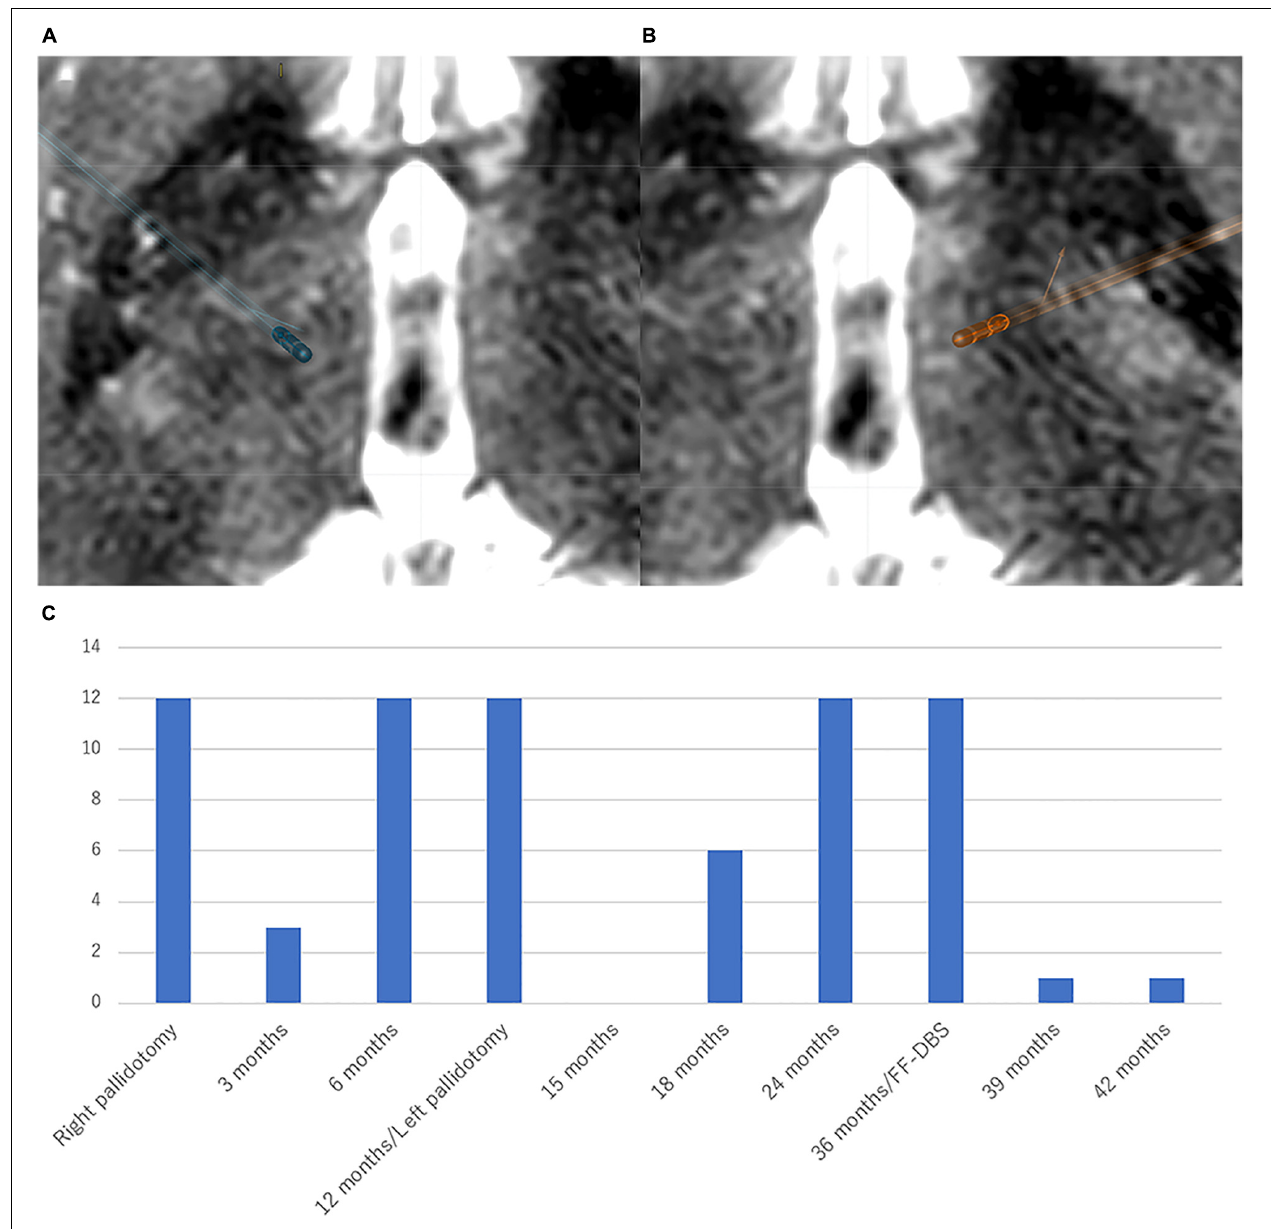
FIGURE 3 | Location of the electrodes and clinical course in Case 3 Patient. The electrodes were simulated by Brainlab elements using postoperative CT scan fused with preoperative T2-weighted MRI. (A) Right-side stimulation (FF): 13-(24%)/14-(23%)/15-(23%)/16-(30%)/C +, 100 µ s, 100 Hz, 2.5 mA. White arrow indicates the lesion of thalamotomy. (B) Left-side stimulation (vim): 2-(34%)/3-(33%)/4-(33%)/C +, 100 µ s, 100 Hz, 2.5 mA. Directional DBS electrodes (Boston Scientific, Marlborough, MA, United States) were used. (C) The patient first received right vim thalamotomy for left-hand tremor. After 24 months post-surgery, tremor and dystonia developed in the left side of the body, which were well improved by right vim-vo thalamotomy. However, left-sided dystonia and right-sided tremor were newly developed 4 months after the second thalamotomy. Right Forel’s field DBS for left-sided dystonia and left vim-DBS for right-sided tremor were performed, which led to complete resolution of tremor and 85.7% improvement of BFMDRS at 6 months after the DBS surgery. BFMDRS, Burke-Fahn-Marsden dystonia rating scale (range: 0–120). FTM, Fahn-Tolosa-Marin tremor rating scale (range: 0–144). DBS, deep brain stimulation. Vim, ventral intermediate nucleus. Vo, ventro-oral